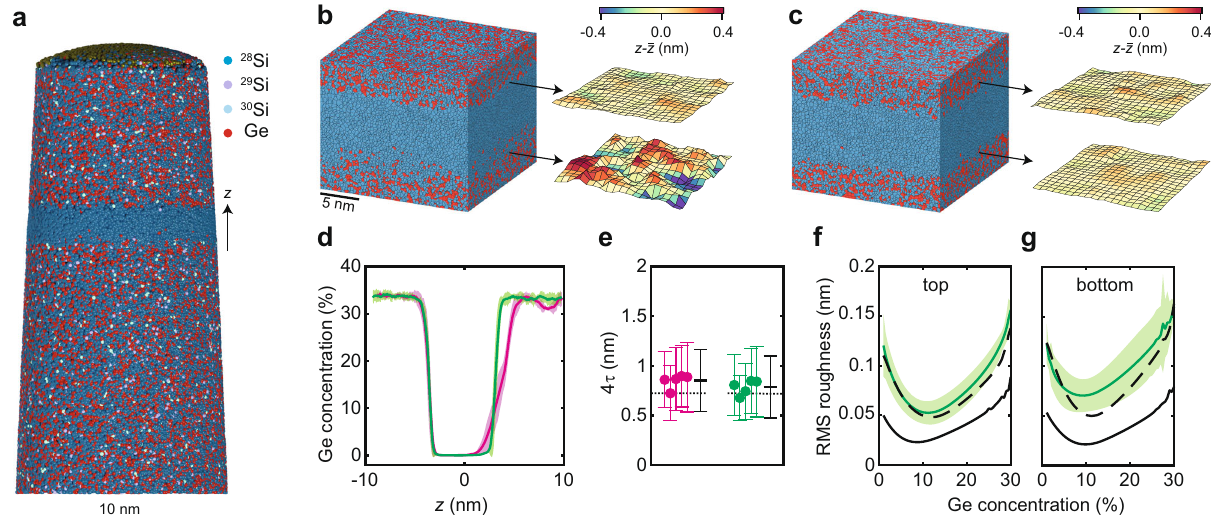
Fig. 2 | Atom probe tomography of 28 Si/SiGe heterostructures. a Point-cloud APT reconstruction of quantum well B, showing the 28 Si quantum well and sur- rounding SiGe barriers. Isotopic puri fi cation is con fi rmed by secondary ion mass spectroscopy (Supplementary Fig. 14). b , c Voronoi tessellation of the APT recon- structions for quantum wells A and B, respectively, and extracted isosurfaces cor- responding to 8% Ge concentration. (cid:1) z is the average position of the 8% Ge concentration across these particular samples. We limit the lateral size of the analysis to ≈ 30nm×30nm, re fl ecting the typical lateral size of a quantum dot (Fig. 1d). d Average germanium concentrationdepthpro fi lesacrossquantumwells A (magenta) and B (green). Shaded areas mark the 95% con fi dence interval over eachofthe setsof fi ve APTsamples. e Statisticalanalysis of thetop interfacewidth